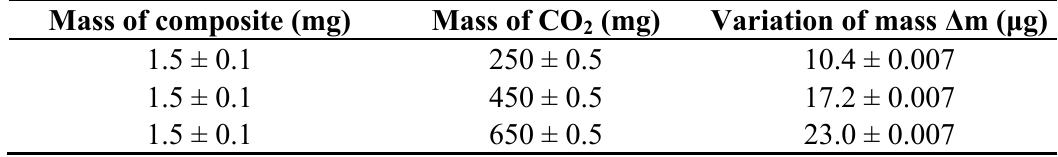
Table 2. Variation of mass in relation to the quantity of CO atmosphere-controlled chamber obtained by depositing the same quantity of